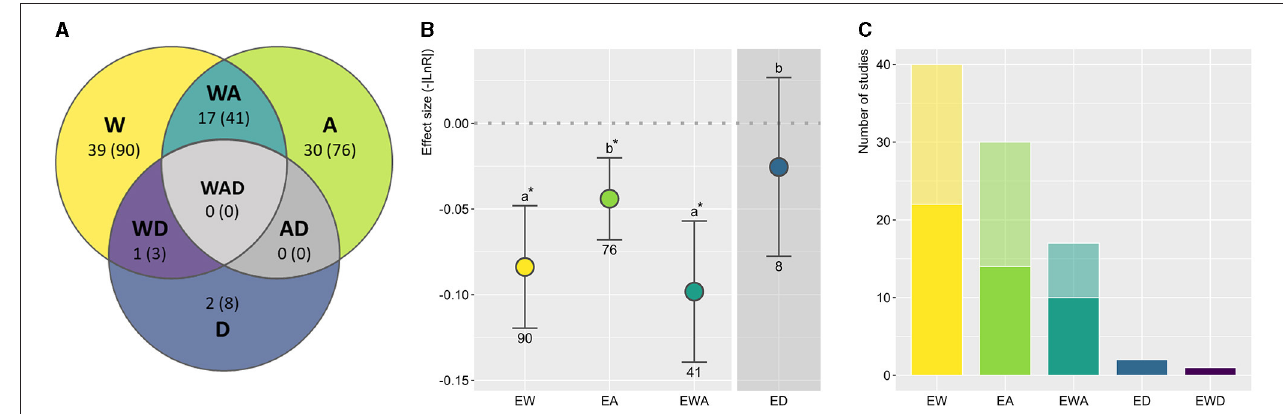
FIGURE 1 | (A) Number of suitable studies (and control-treatment contrasts) per treatment, featuring experimental warming (EW), acidification (EA), and deoxygenation (ED), along with their combination (EWA, EWD, and EWAD). (B) Elasmobranch overall response to each experimental treatment standardized according to the stressor ratio (SR) implemented in each study. Effect sizes represent the absolute value of the response ratio (-|LnR|) and 95% confidence intervals (CI). Significant effects, marked with asterisks, correspond to the absence of overlap between the CIs and the threshold used to test the null hypothesis (dashed line; effect size = 0). Different letters showcase differences between treatments; numbers indicate sample sizes (control-treatment contrasts). Statistical results are detailed in Supplementary Table 1 . With only two studies available for ED, the obtained results should be interpreted with special caution. With only one study, WD was entirely excluded from the analysis. (C) Number of studies per treatment featuring a lower (light) or higher (dark) SR than the worst-case scenario (Representative concentration pathway 8.5) predicted by the Intergovernmental Panel on Climate Change for the end of the